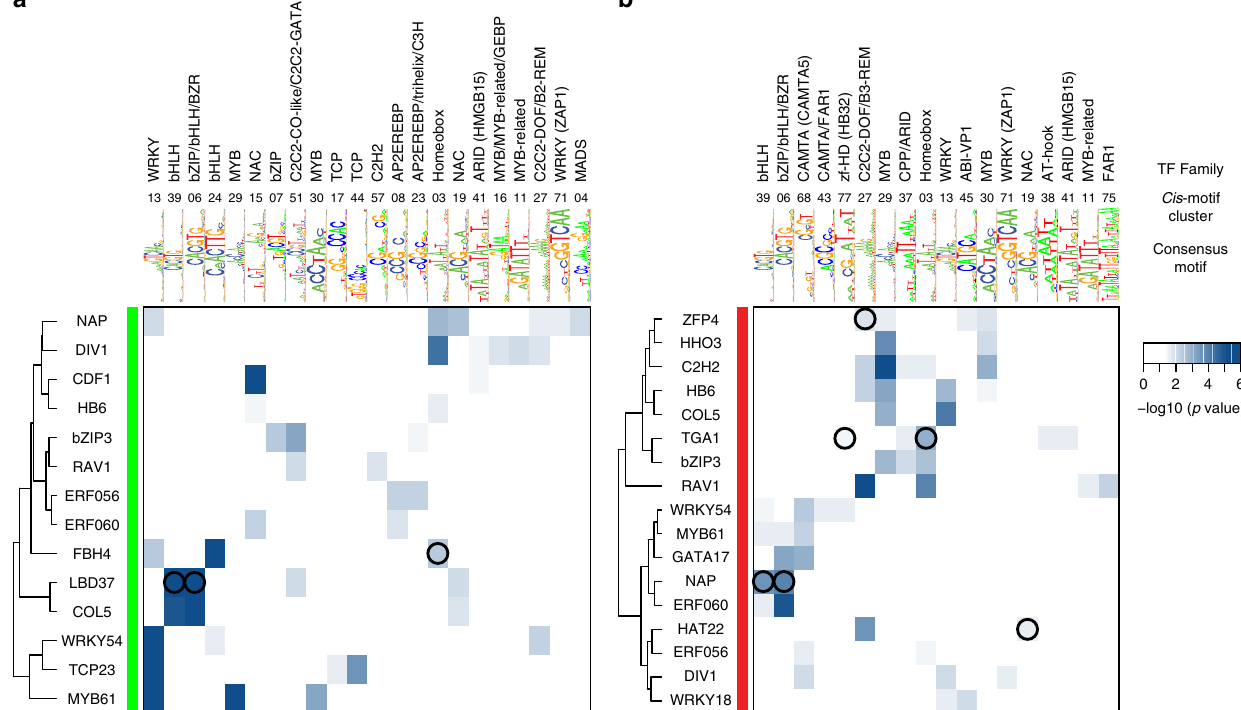
Fig. 5 Direct regulated transcription factor (TF) targets are enriched for cis -motif clusters of partner TFs. Heatmap of enriched consensus cis -motifs for the 80 cis -motif clusters (columns) in the 500 bp promoter of the a induced and b repressed direct regulated targets of the 33 nitrogen (N)-early response TFs. The consensus cis -motif (CCM) logo, cluster number, and family representation for each CCM is shown above. Instances where there is a validated interaction between the TF under study and another TF within a family represented by the enriched CCM cluster are marked by a black circle. Of the 33 TFs validated in TARGET, only TFs with enrichment of any of the 80 CCMs in the 500 bp promoter are shown. Cis -binding motif clusters were determined using cis -motifs for Arabidopsis transcription factors collected from DNA af fi nity puri fi cation sequencing (DAP-seq) 5 , Cis-BP 38 , and protein binding microarrays (PBM) 39 . Blue shading represents p values calculated using Fisher ’ s exact test and false discovery rate (FDR) corrected. Source data of Fig. 5a, b are provided as a Source Data fi